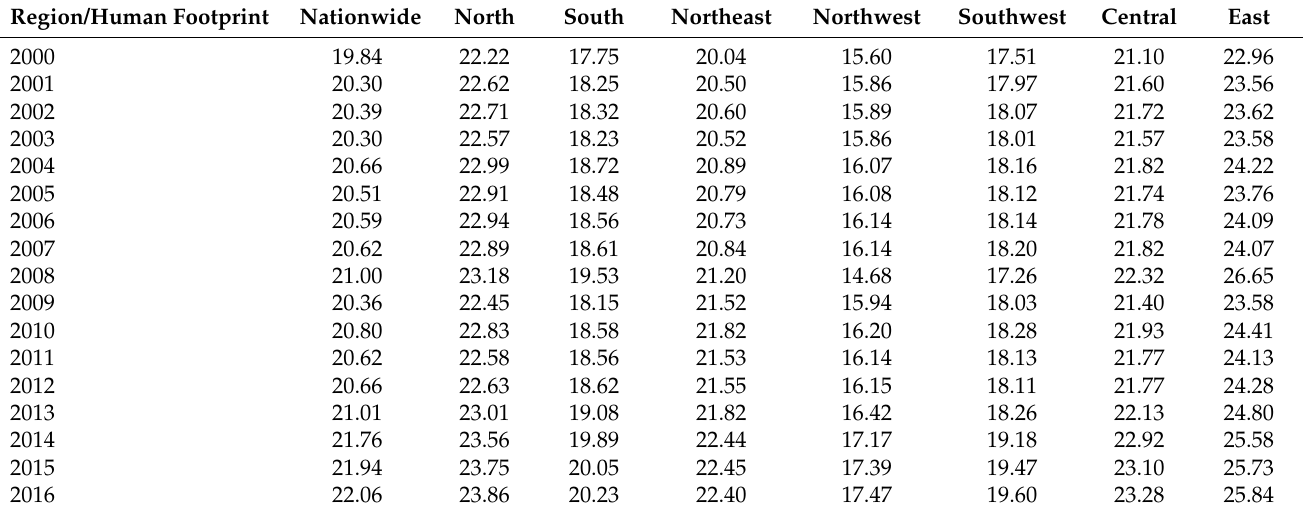
Table 1. Average human footprint index in different regions of China during